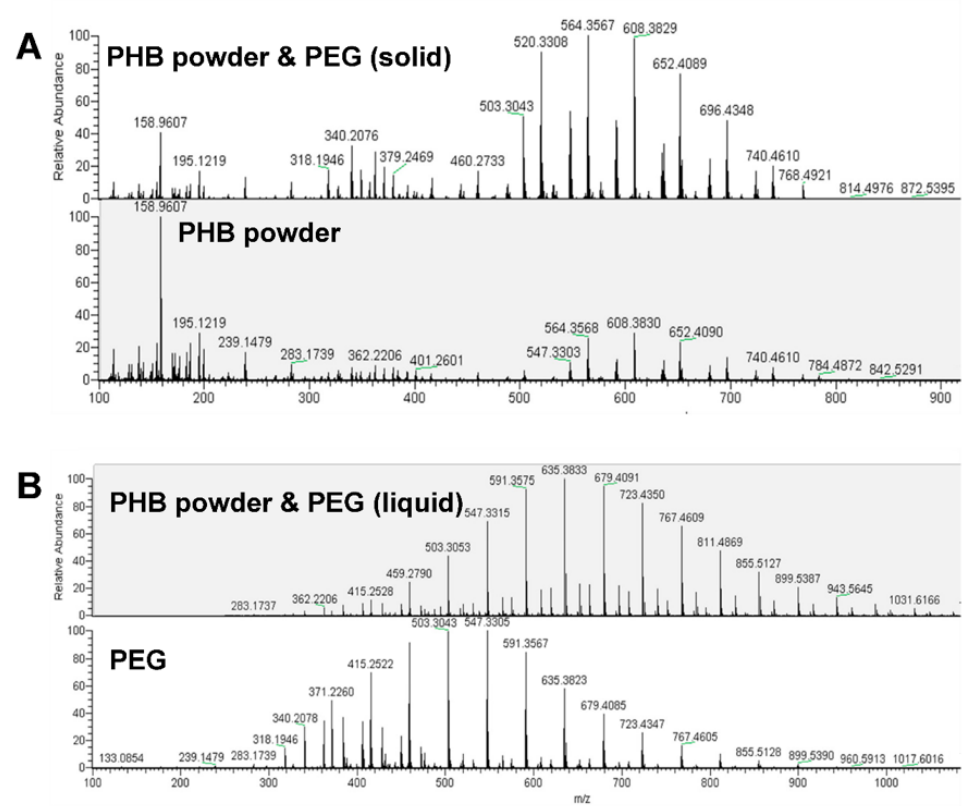
Figure 4. Mass spectrum of PHB powder and PEG after heat treatment. ( A ) Comparison between PHB power and the solid part of mixture of PHB powder and PEG after heat treatment. ( B ) Comparison between PEG and the liquid part of mixture of PHB powder and PEG after heat treatment.